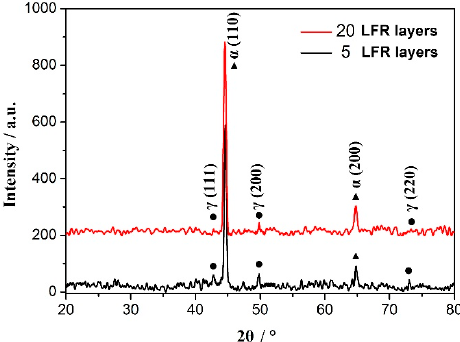
Figure 7. X-ray diffraction (XRD) patterns of the top regions of two kinds of LFR layered samples.